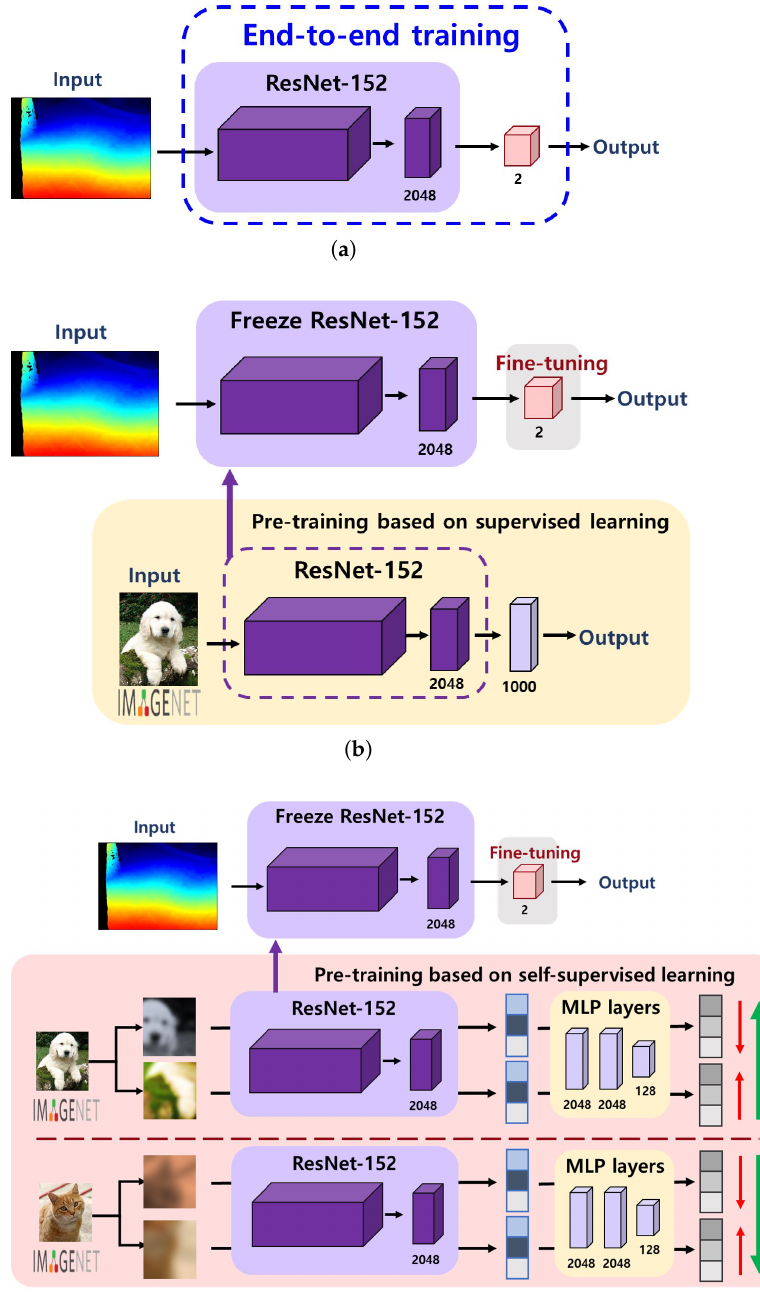
Figure 5. Training strategies. ( a ) Supervised learning from scratch, ( b ) Transfer learning with supervised pre-trained models, ( c ) Transfer learning with self-supervised pre-trained